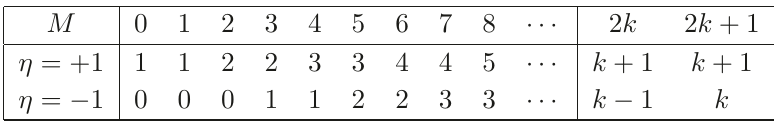
Table 1 . The relation between flux numbers and the numbers of zero-mode wave functions. Also, we similarly compute a scalar wave function as the same as the fermionic one in eq. (2.9). There is no massless (zero-)mode in the scalar field. In other words, the